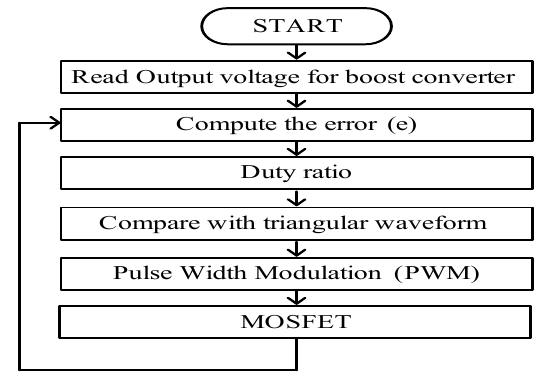
Figure 6. Flowchart of the control algorithm for the PEHS.